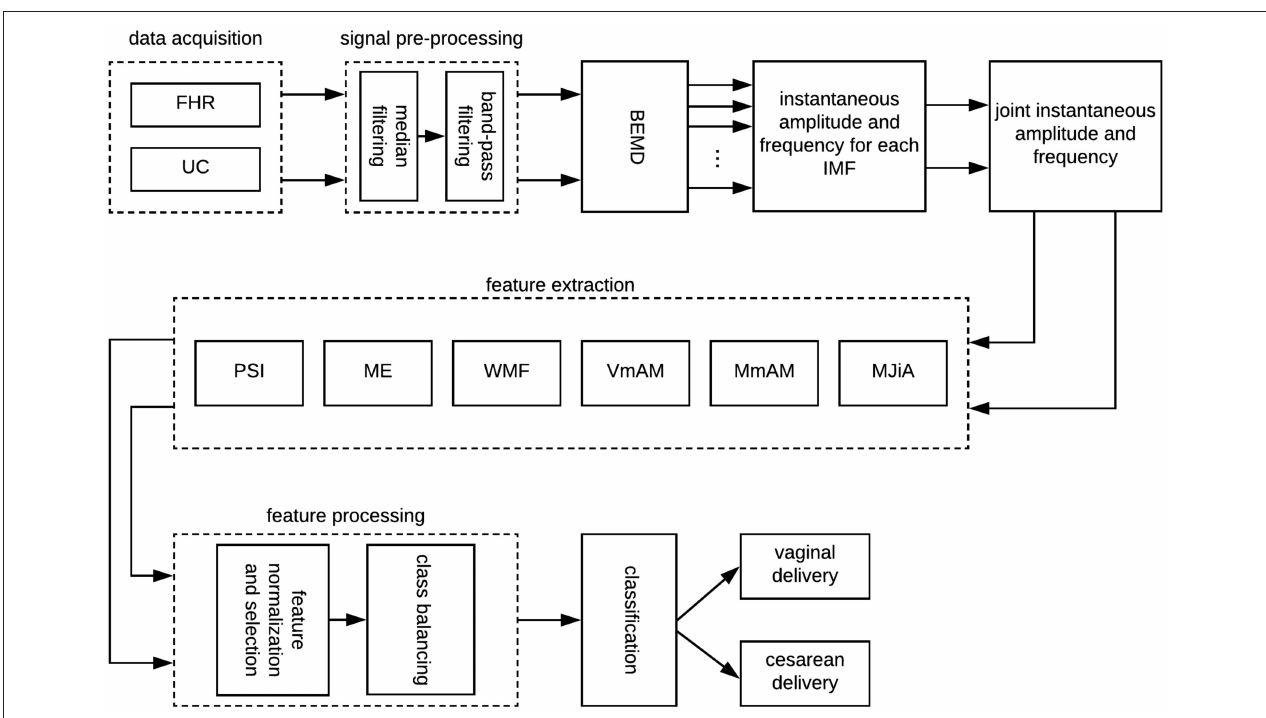
FIGURE 1 | A schematic of the proposed scheme in this study. FHR, fetal heart rate; UC, uterine contraction; BEMD, bivariate empirical mode decomposition; MJiA, mean of joint instantaneous amplitude; MmAM, mean of monotonic change in AM; VmAM, variance of monotonic AM change; WMF, weighted mean frequency; ME, mean energy; PSI, phase synchronization index; IMF, intrinsic mode